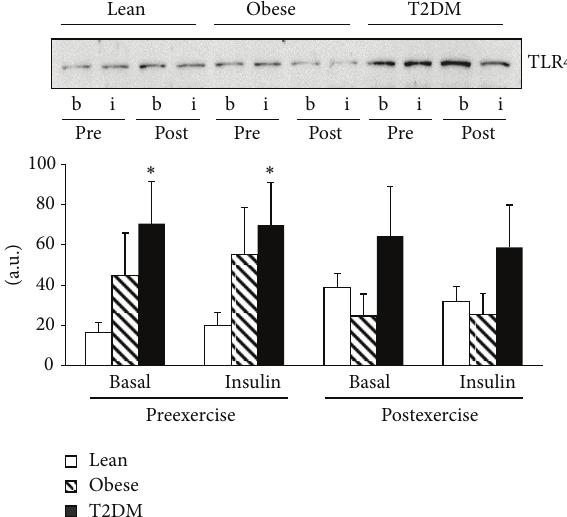
Figure 2: TLR2 protein content. TLR2 was measured in PMNC from 17 lean, 8 obese, and 11 T2DM individuals at the basal state (b) and at the end of the insulin clamp (i) before (pre) and after (post) exercise training. Data are means ± SE. Blots are shown for one lean, one obese, and one T2DM individual. a.u.: arbitrary